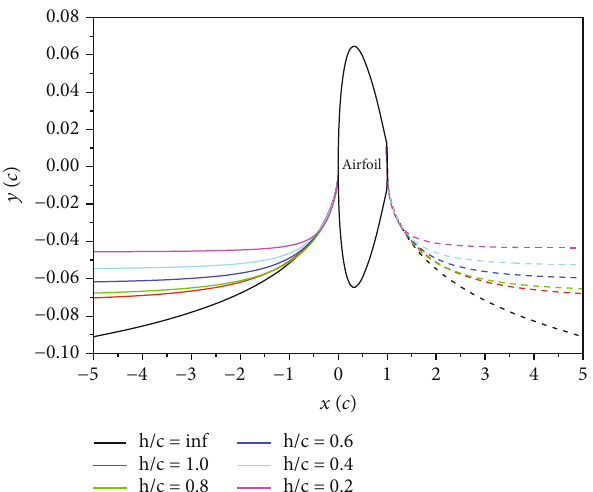
Figure 20: Leading edge stagnation streamlines and the streamlines beginning from the jet separation point on the Coanda surface for C = 0 : 014 at α = 0 ° . μ